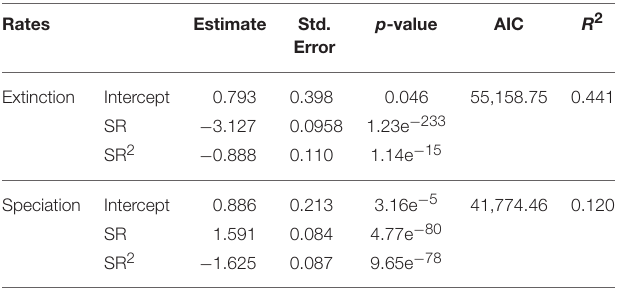
TABLE 3 | Regression coefficients based only on linear models quantifying the relationship between diversification rates (i.e., extinction and speciation) and SR. Rates Estimate Std. Error p -value AIC R 2 Extinction Intercept